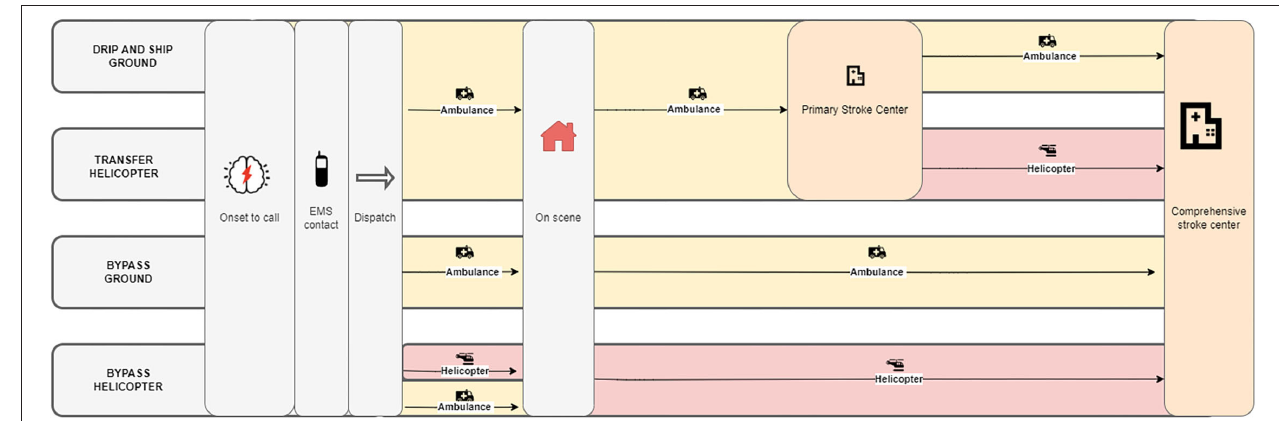
FIGURE 1 | Comparing ground transport to helicopter transport to the nearest comprehensive stroke center (CSC). In the helicopter model, an ambulance is dispatched at the same time as the helicopter, and the ambulance personnel has prepared the patient for helicopter transport (minimum 28min).